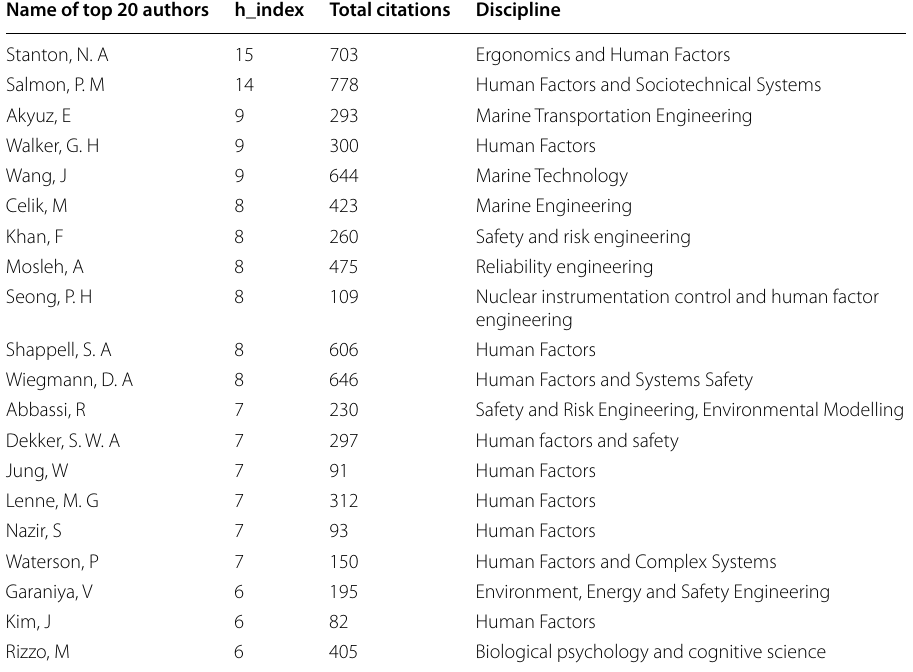
Accidents” based on h‑index +